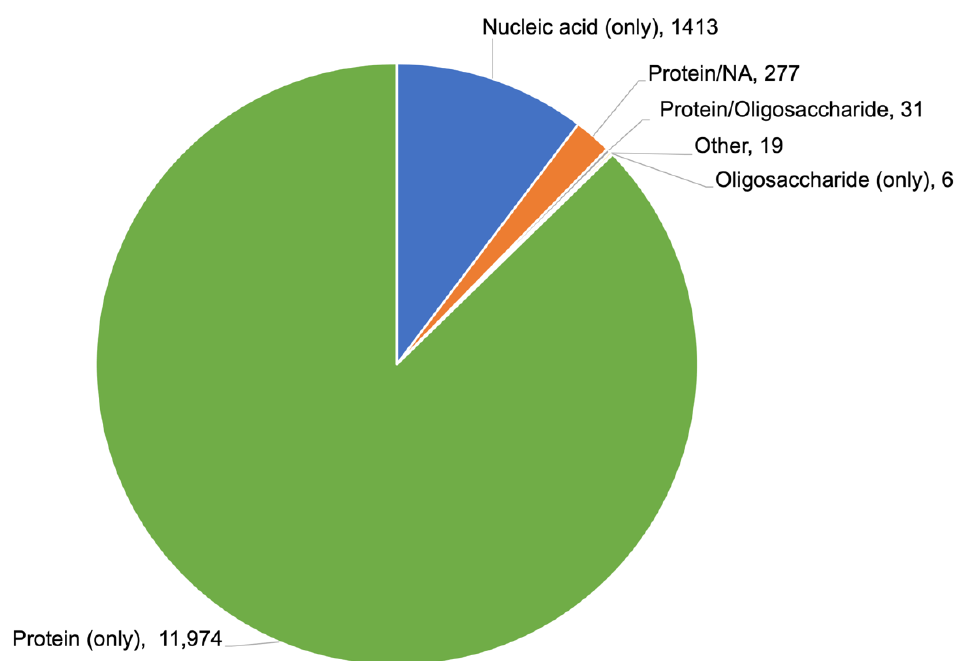
Figure 6. Breakdown of NMR PDB structure holdings by sample type.